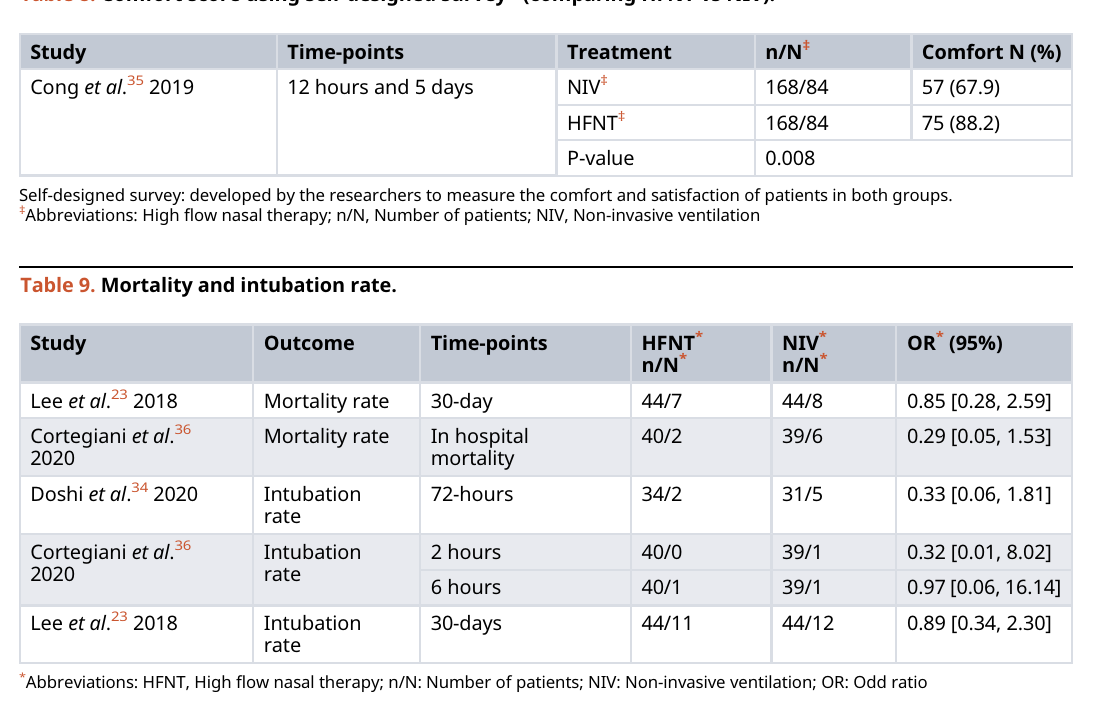
Table 8. Comfort score using self-designed survey* (comparing HFNT vs NIV). 35